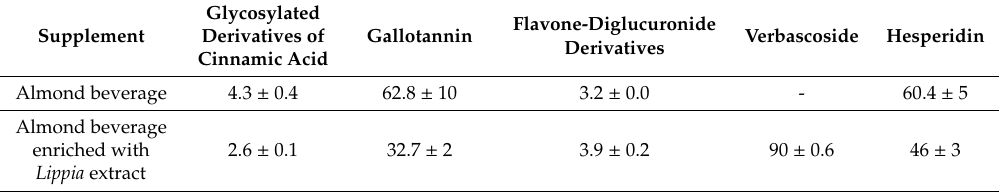
Figure 1. Chromatogram of the almond beverage enriched with Lippia citriodora. Hexane extraction was performed twice in 10 mL of the beverage to obtain the aqueous phase. Polyphenols were obtained by methanol:H 2 O: trifluoroacetic acid (70:30:0.3) extraction by incubating 12–16 h, at 4 ◦ C in darkness. Then, samples were centrifuged and supernatant was eliminated by vacuum exposure at 35–40 ◦ C. Pellets were suspended in 5 mL of methanol:H 2 O (1:1) and filtered. In total, 10 µ L were analyzed in triplicate by HPLC-DAD-ESI-MS / MS. Verbascoside was present only in Lippia extract (see Table 1). Table 1. Concentrations of the main peaks indicated in Figure 1. Results expressed in mg / L of almond beverage without and with Lippia extract after duplicate polyphenol extraction and triplicate HPLC-DAD-ESI-MS / MS analysis.